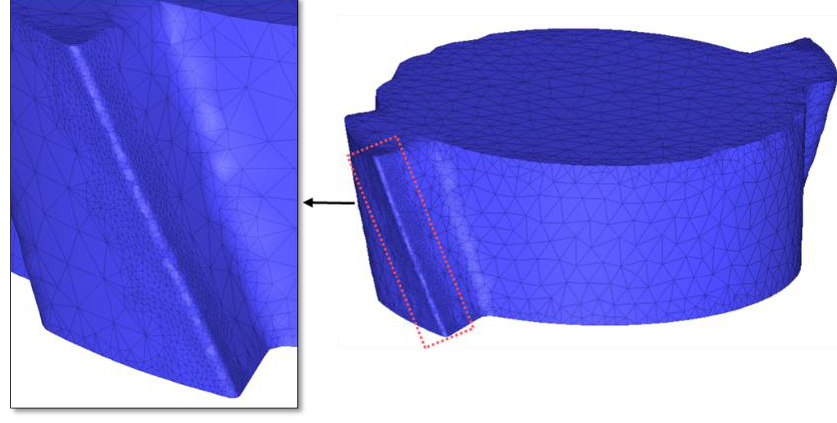
Figure 4. Meshing of the micro-milling cutter and partial enlargement of cutting edge.